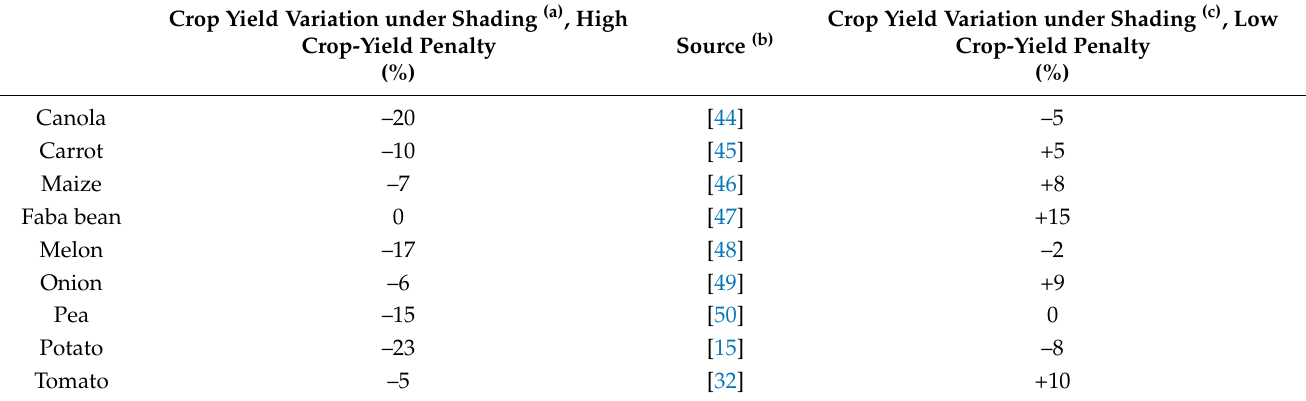
Table 6. Crop yield variation under APV partial shading with respect to full